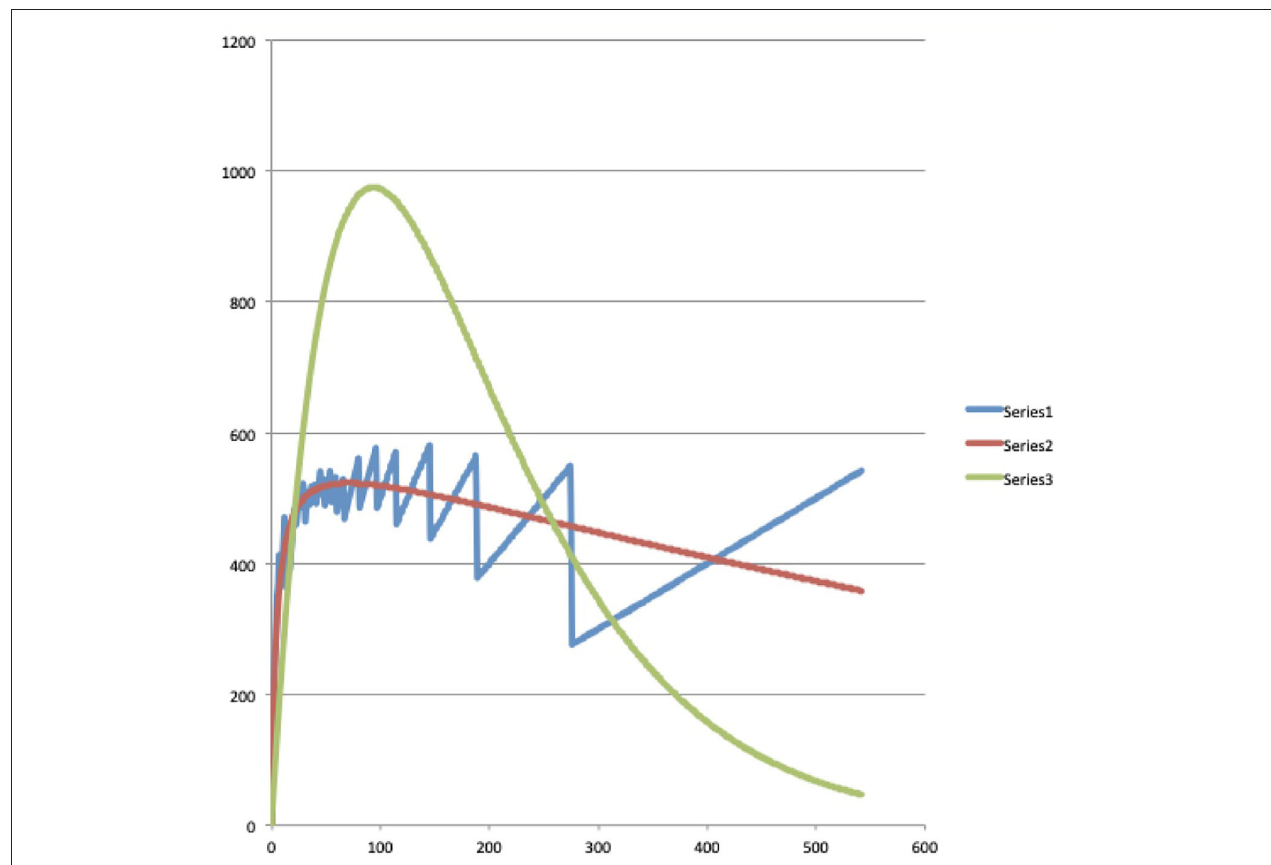
FIGURE 4 | A representation of the “energy distribution” of the Winnie the Pooh story “In Which Piglet Meets a Haffalump” (Milne, 1926) as listed in Table 1 . The blue graph (Series 1) represents the energy radiated by the story per energy level (column “ E ( E i )” of Table 1 ), the red graph (Series 2) represents the energy radiated by the Bose-Einstein model of the story per energy level (column “Energ B-E” of Table 1 ), and the green graph (Series 3) represents the energy radiated by the Maxwell-Boltzmann model of the story per energy level (column “Energ M-B” of Table 1